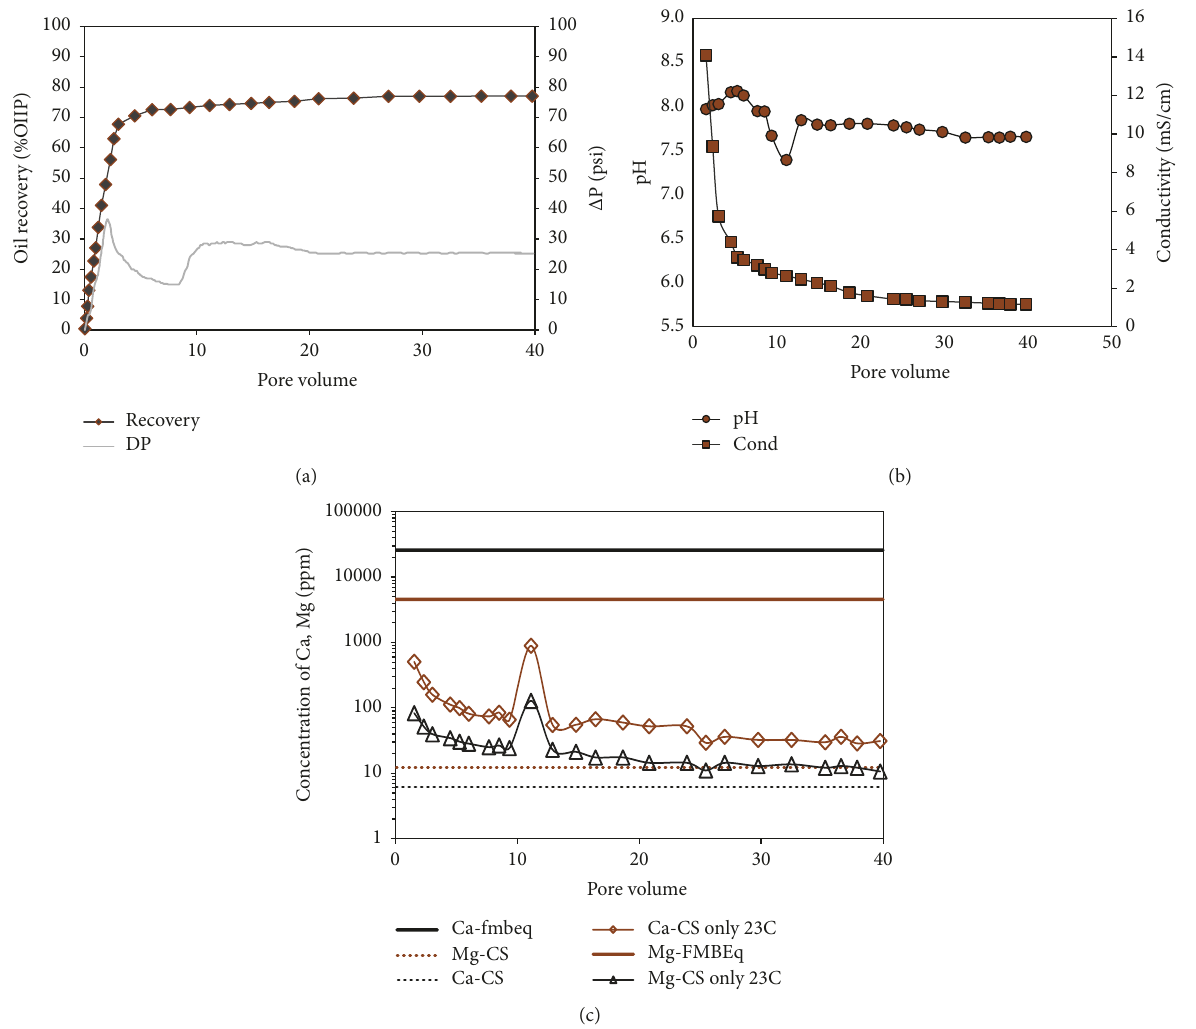
Figure 7: Secondary CSB flooding on core C27, (a) cumulative oil recovery and differential pressure; (b) pH and conductivity of effluents; (c) Ca 2+ and Mg 2+ analyses of effluents. The straightlines indicateconcentrationof Ca 2+ (coloured) and Mg 2+ (black)in connatewatersaturation (—) and CSB injected